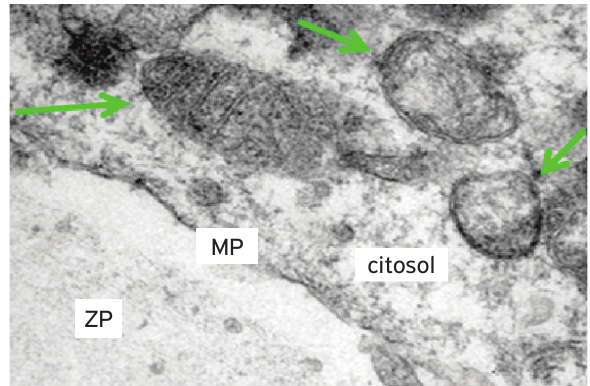
Figura 14. Embrião exposto aos vírus e ao ao extrato etanólico da casca de Punica granatum (Grupo G membrana plasmática. Setas verdes: mitocôndrias. Todas as